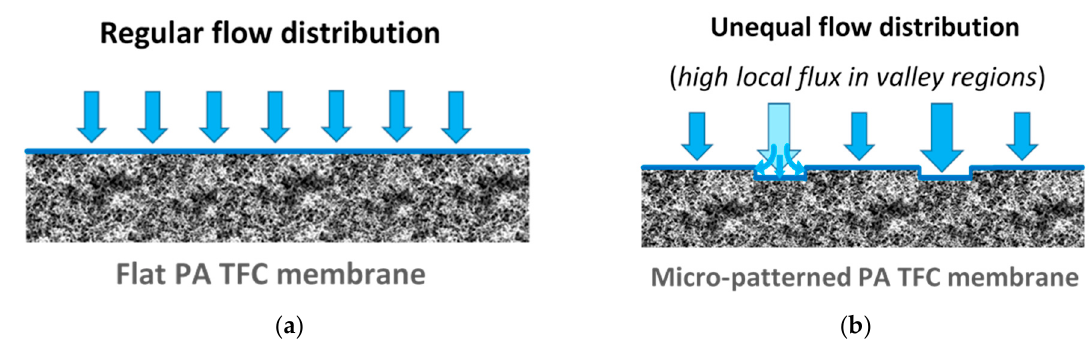
Figure 5. Schematic illustrations for suggested feed flow distribution atop flat PA TFC membrane surface ( a ) vs. micro-patterned PA TFC membrane surface ( b ).